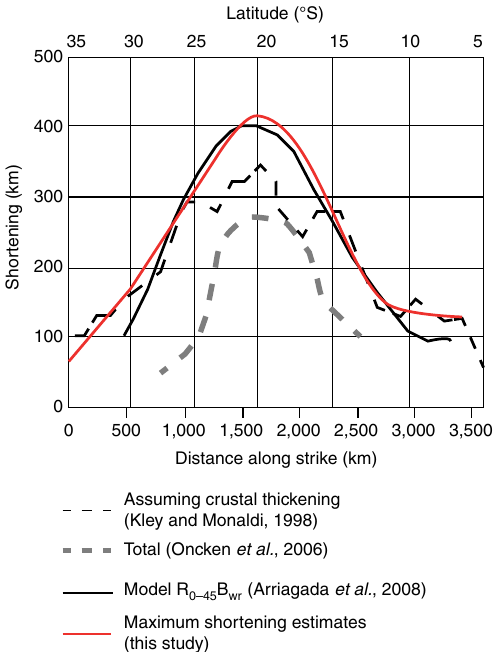
Figure 4 | Shortening along the Central Andes. Shortening estimated in various compilations (Modified from Arriagada et al. 30